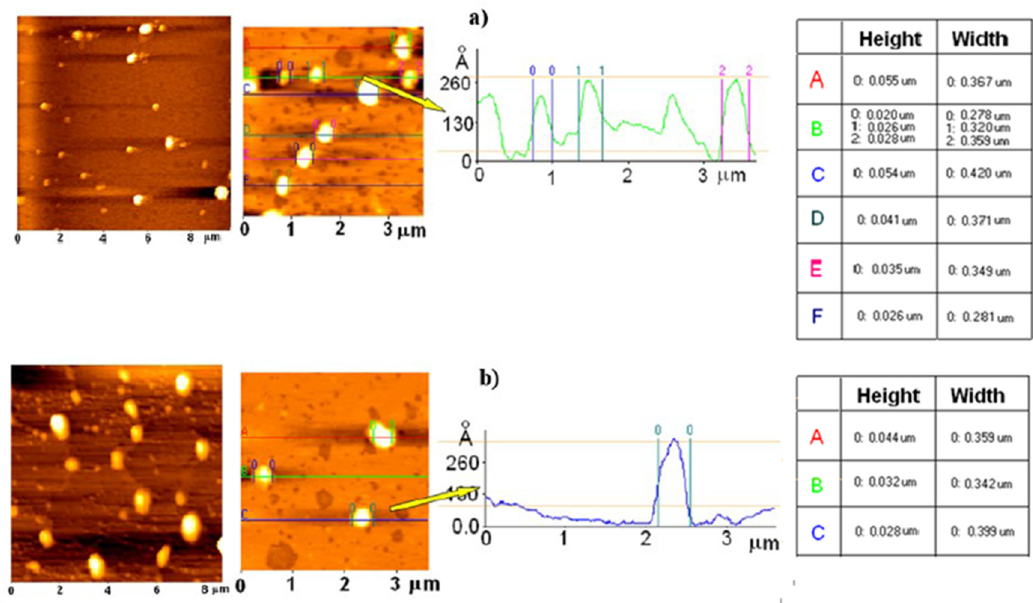
Figure 1. Atomic Force Microscopy (AFM) images, height profile and elaboration of ( a ) unloaded LN and ( b ) Capsaicin loaded lipid nanocarriers (CPS-LN).